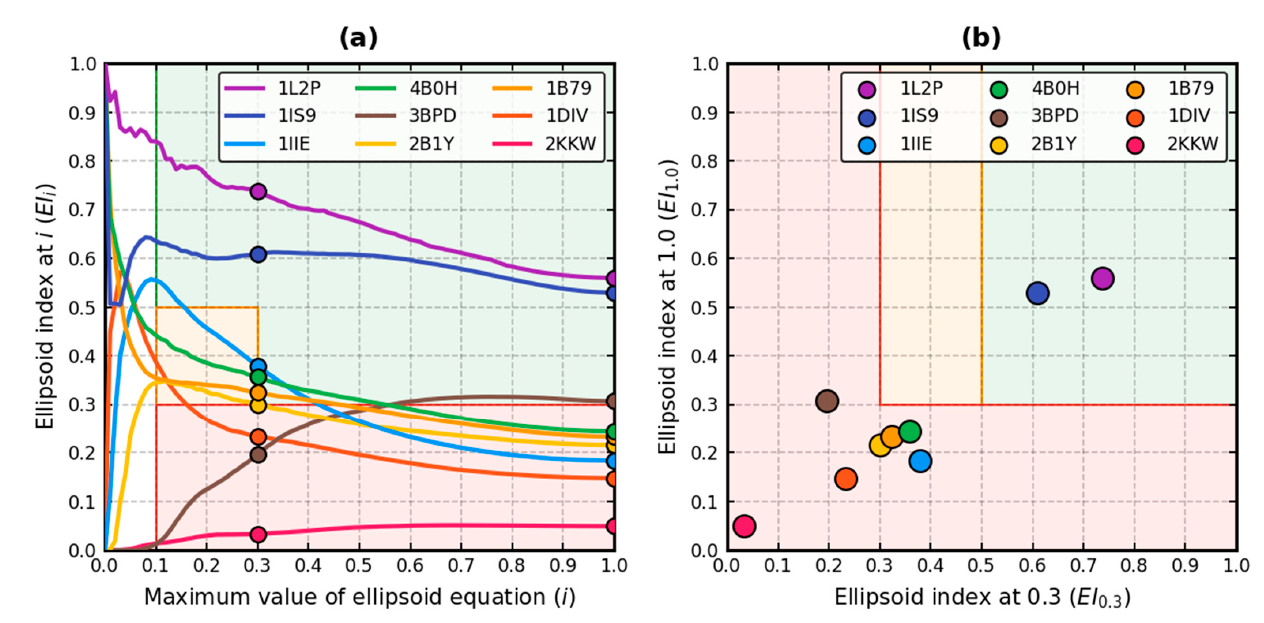
Figure 6. Ellipsoid profiles ( a ) and corresponding ellipsoid profile maps ( b ) of proteins from Table 4 using m = 0. Four colored zones can be seen underneath the profiles in Figures 5a and 6a: red, orange, green and white/transparent. These zones are visual cues for classification and comparison of proteins by the means of EP algorithm. They are coupled with two special values of parameter i : 1.0 and 0.3. EI 1.0 is the “main” index, reflecting everything that hap-